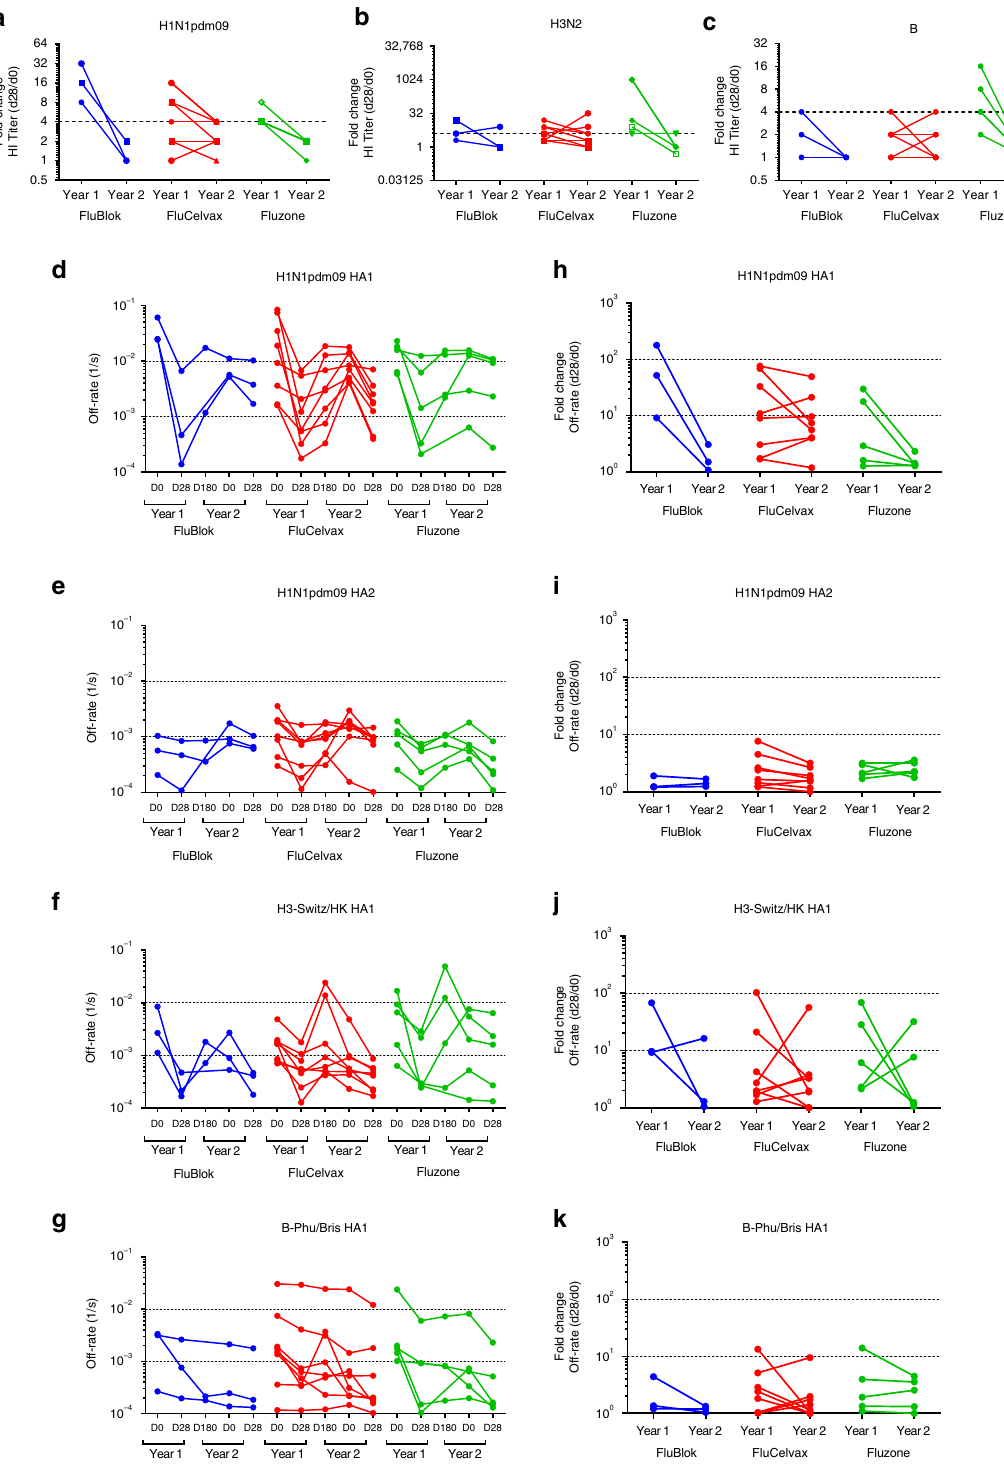
( n = 8) are not included in this analysis. Day 0 pre-vaccination against H3N2 are also impacted by prior vaccination more clearly HI titers are not statistically different against the three in fl uenza in the FluBlok group (Supplementary Table 8, Fig. 5b). For anti-B vaccine strains irrespective of the vaccine. Interestingly, only in response, decreased seroconversion rates are found for indivi- the FluBlok/FluCelvax groups, the fold increases in HI titers duals reporting prior-year vaccination across all three vaccine against the H1N1pdm09 strain are higher for individuals with no platforms, but the decline in fold change reached statistically prior-year vaccination compared with individuals with prior year signi fi cant only for the FluBlok and FluCelvax groups (Supple- vaccination (Supplementary Table 8, Fig. 5a). HI responses mentary Table 8, Fig. 5c). NATURE COMMUNICATIONS| (2019) 10:3338